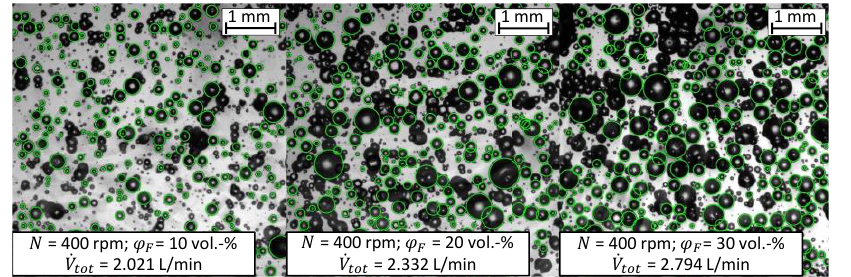
Figure 4. Examples of the image analyses by the CNN-based method. The images were taken at different feed phase fractions at measurement position 𝑀𝑃 1 .